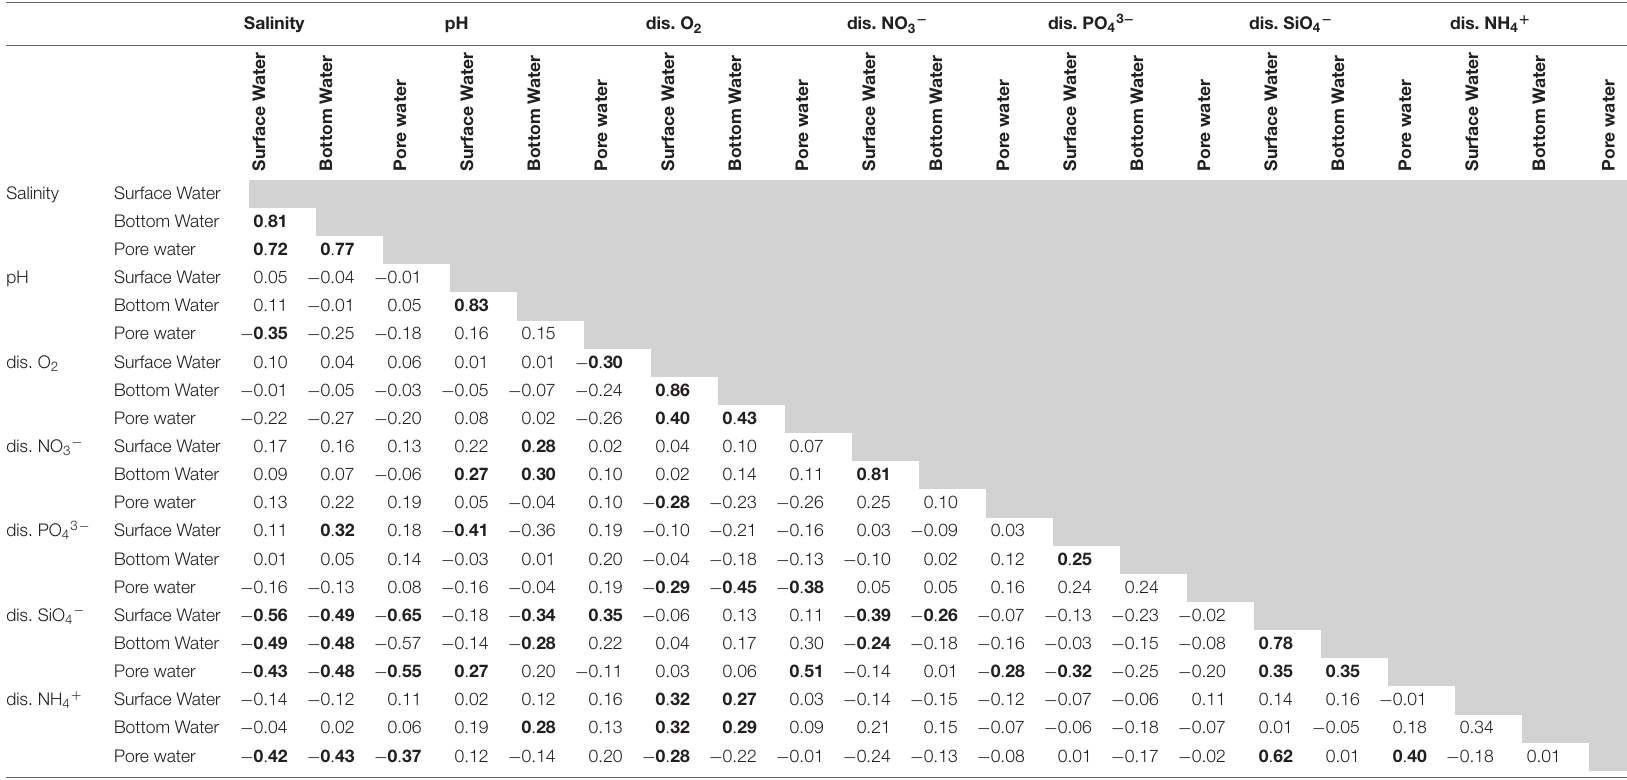
TABLE 2 | Values of Pearson’s correlation co-efficient between the environmental and nutrient parameters observed in the lagoon for the studied period. Salinity